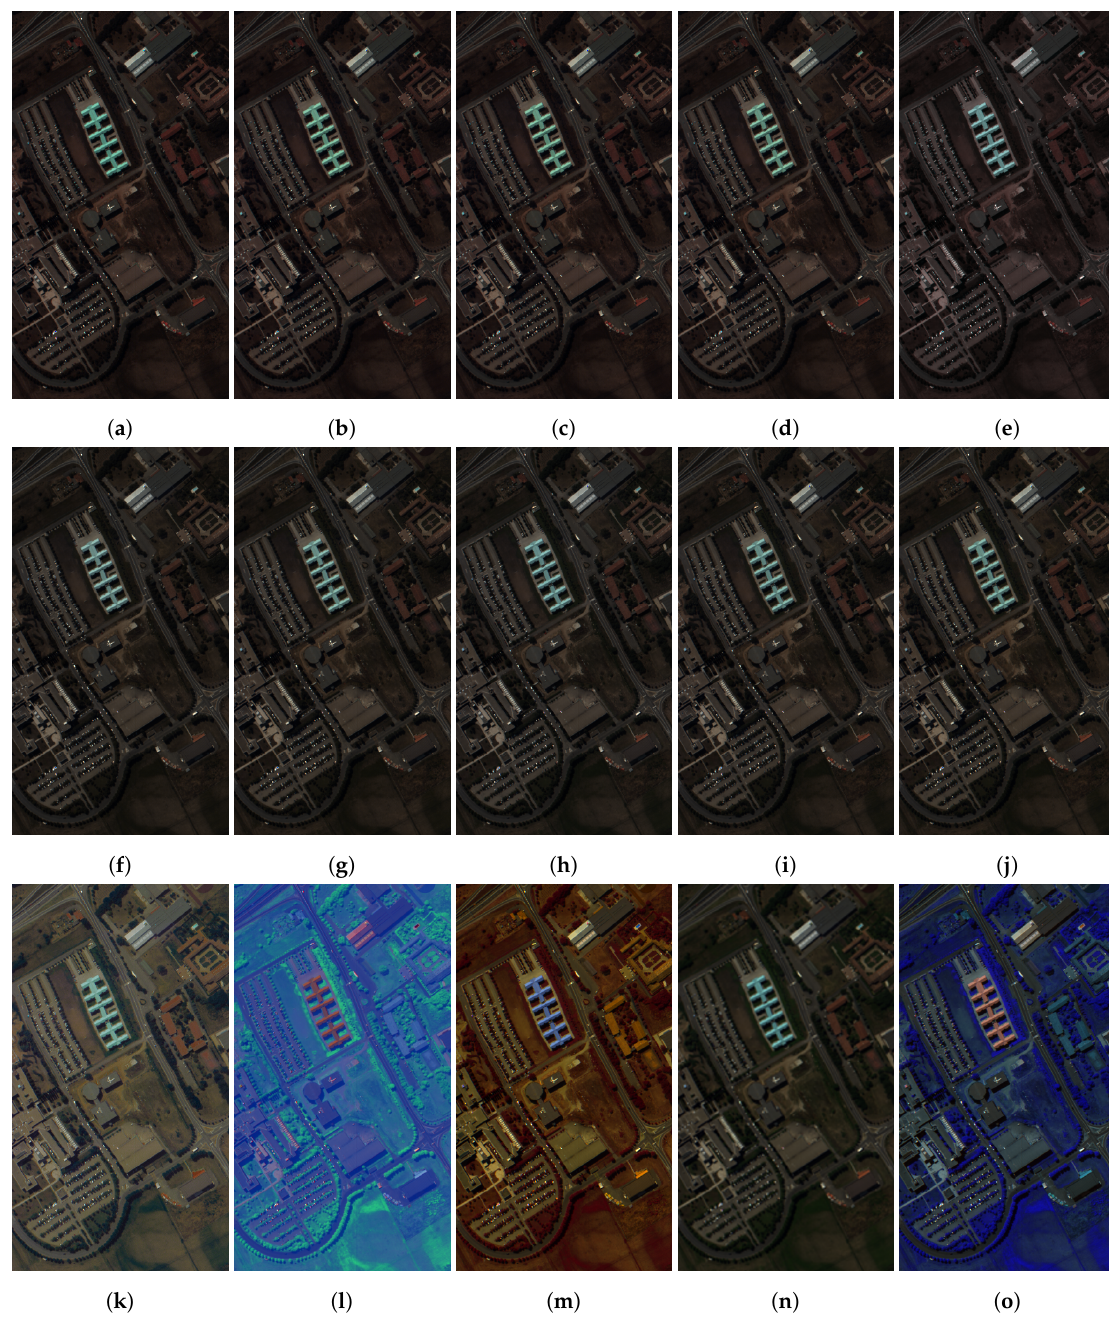
Figure 9. Experimental results on the Pavia University image. ( a ) BS. ( b ) NOL. ( c ) SOL. ( d ) MOL. ( e ) HOL. ( f ) Canon 5D. ( g ) Canon 1D. ( h ) Hasselblad H2. ( i ) Nikon D3X. ( j ) Nikon D50. ( k ) ANN. ( l ) PCA [15]. ( m ) CMF [18]. ( n ) CML [25]. ( o ) DHV